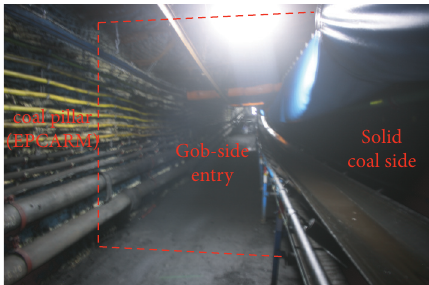
Figure 9: Control effect of the on-site surrounding